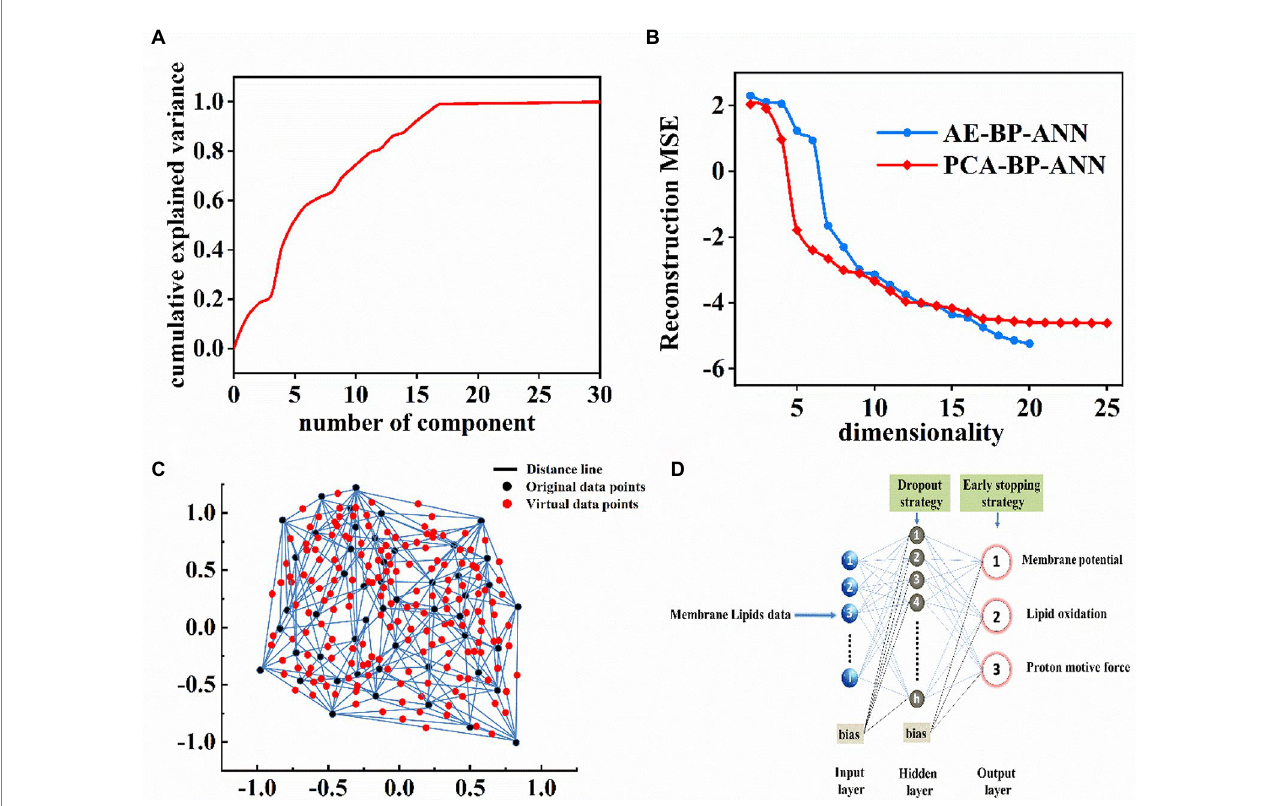
FIGURE 5 (A) The relationship of principal components number and cumulative explained variance (%). (B) Reconstruction MSE in the logarithmic scale as a function of the input data dimension number based on PCA-BP-ANN and AE-BP-ANN models. (C) Two-dimensional interpolation graph of virtual sample points. (D) BP-ANN topology